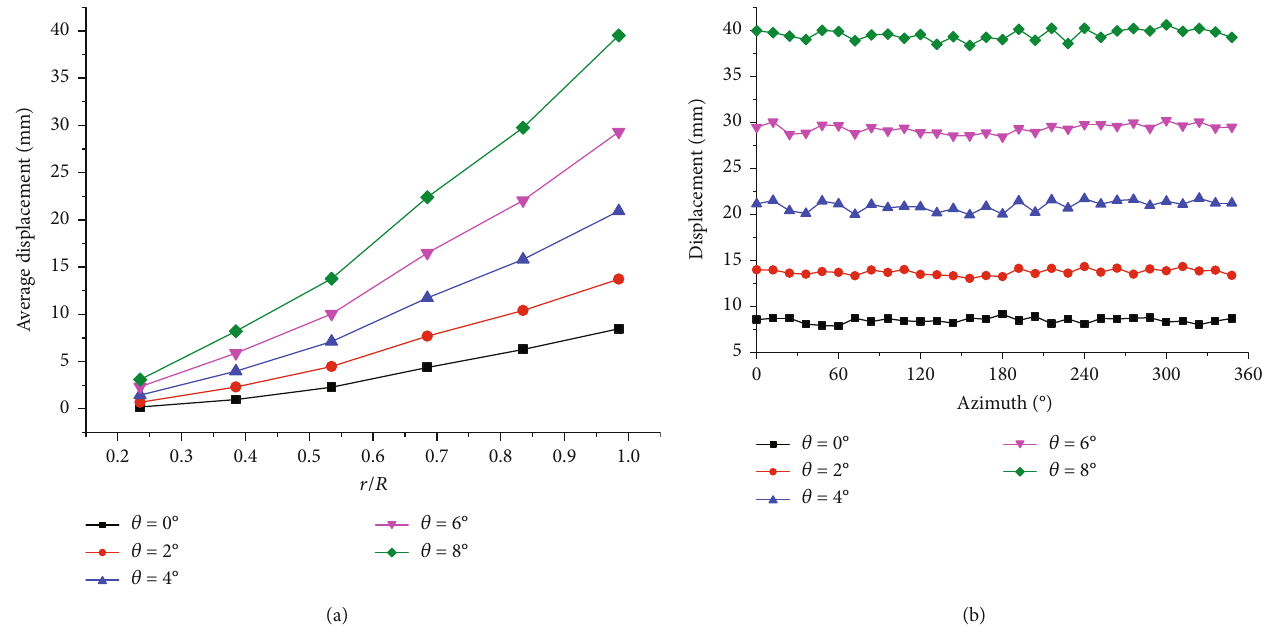
Figure 17: (a) Comparison of average displacements at six di ff erent radial locations. (b) Blade tip displacements at fi ve di ff erent collective pitch angles in hover fl ight.